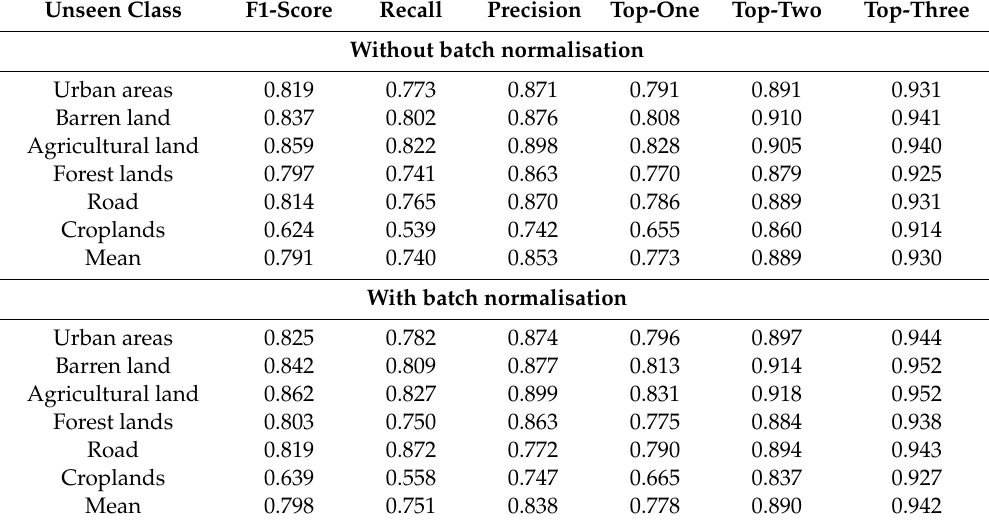
Table 8. Accuracy of the model without and with batch normalisation for the first test area (Cameron Highlands).